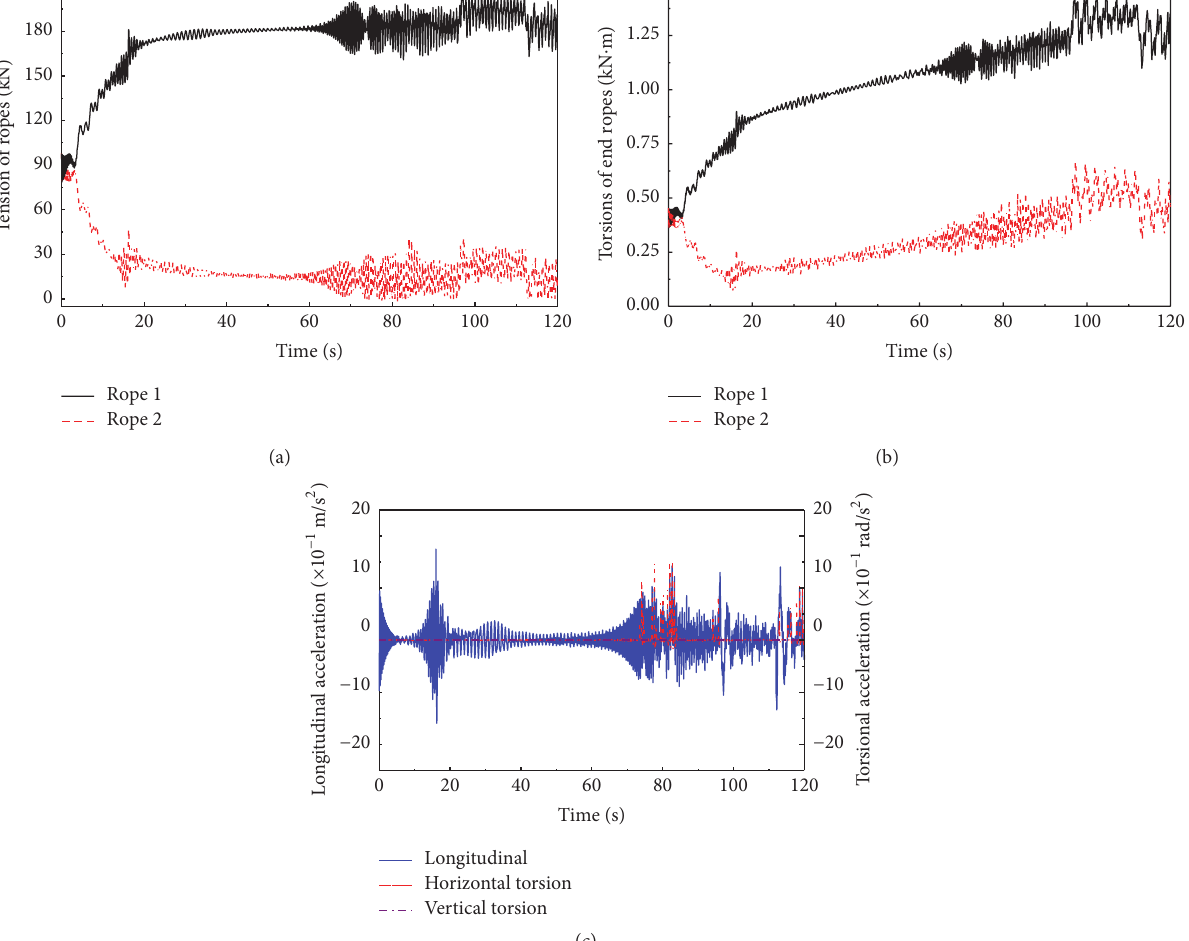
multiple resonance locations during time interval 60 ∼ 90